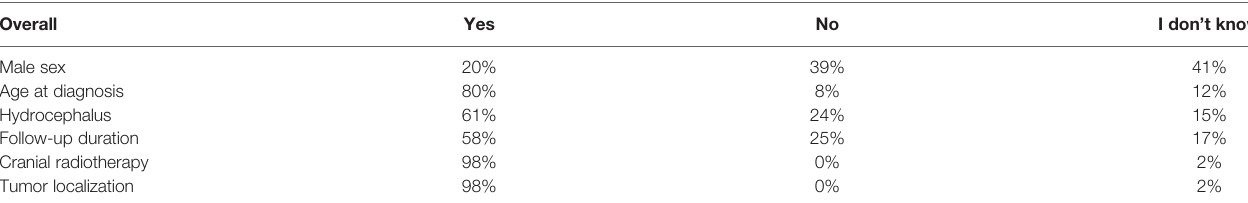
TABLE 2 | Q5: Independent risk factors for GHD in BTS.